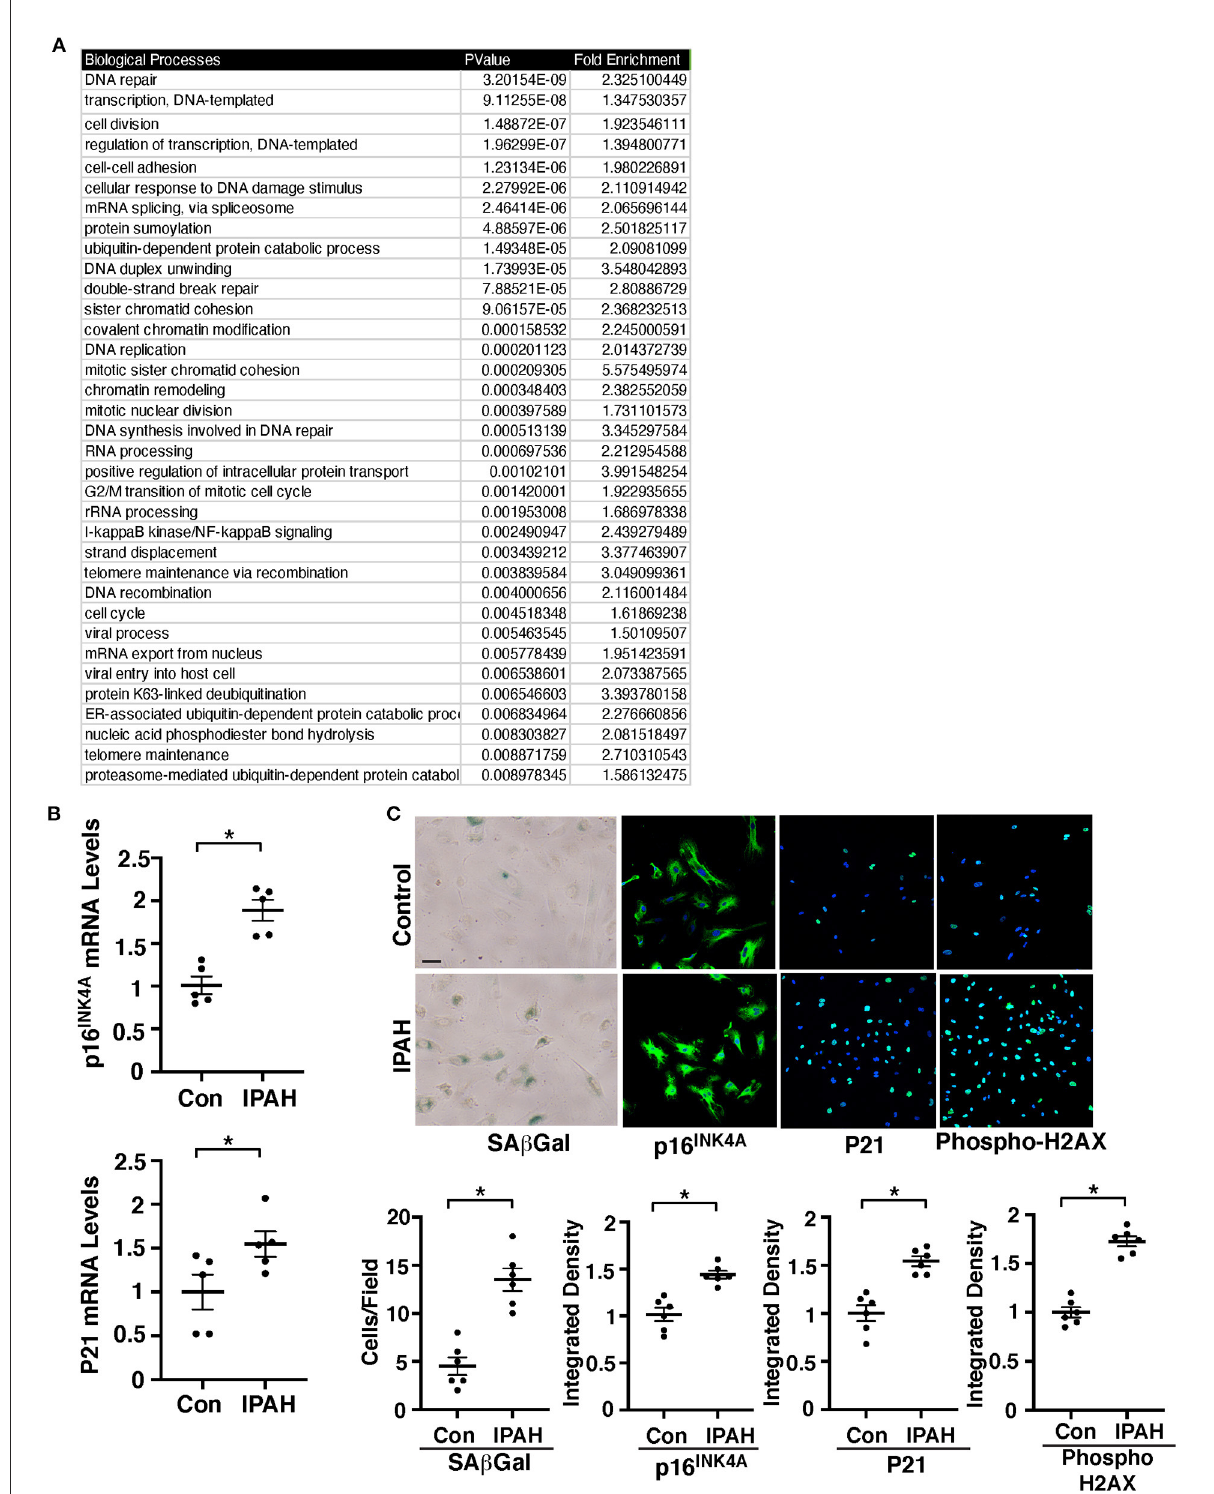
FIGURE1 EC senescence increases in IPAH patient lung ECs. (A) List of top 35 BP GO term categories derived from significantly differentially expressed genes related to cellular senescence and SASP in control vs. IPAH patient lungs. (B) Graphs showing the mRNA levels of p16 INK4A ( top ) and p21 ( bottom ) in PAECs from IPAH patients or healthy individuals ( n = 5, * p < 0.05). Error bars represent SEM. (C) Micrographs of PAECs from IPAH patients or healthy individuals showing SA β Gal activity ( left ). Immunofluorescence (IF) micrographs of p16 INK4A expression and DAPI ( 2nd ), p21 expression and DAPI ( 3rd ), and the levels of phospho-gamma H2AX and DAPI ( right ). Scale bar, 20 µ m. Graphs showing the number of SA β Gal-positive cells and integrated fluorescent density of p16 INK4A , p21, and phospho-gamma H2AX ( n = 6, * p < 0.05). Error bars represent